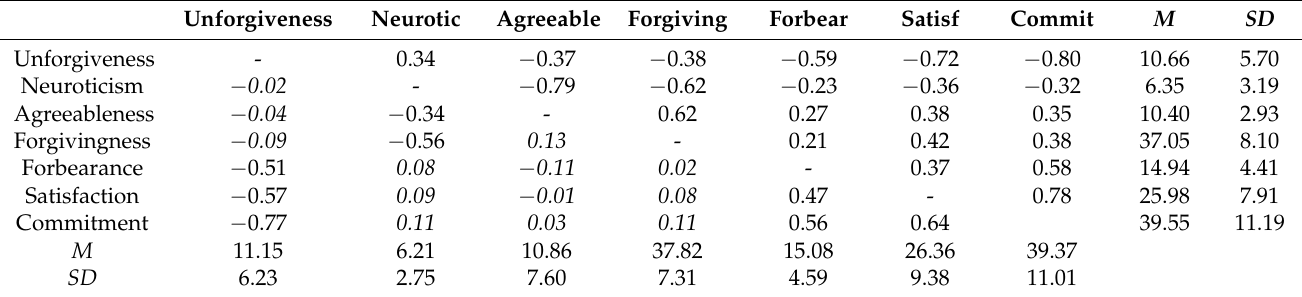
Table 1. Descriptive Statistics and Intercorrelations of Variables for Men and